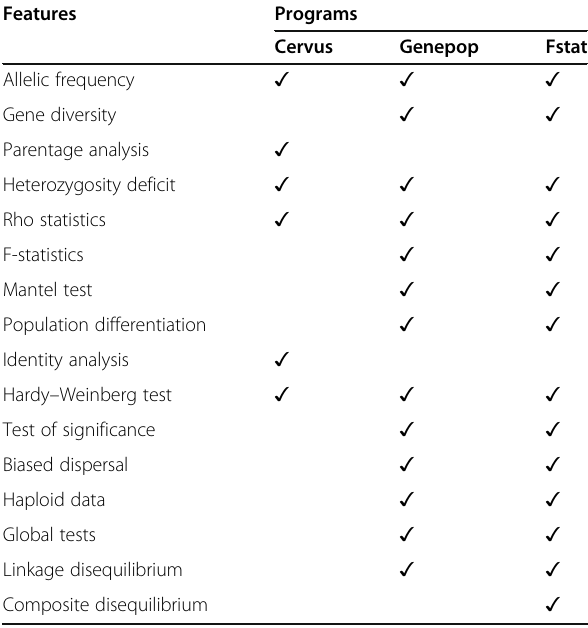
Table 1 Major features of reviewed software